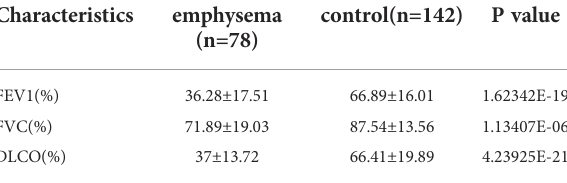
TABLE 1. Clinical characteristics of 220 samples in GSE47460